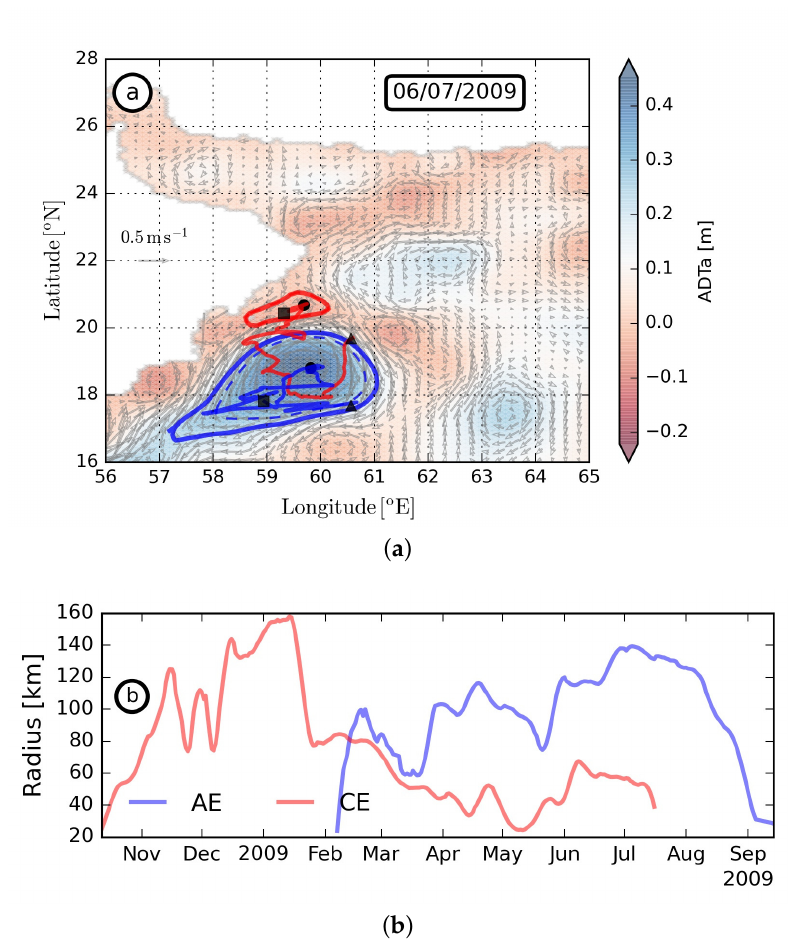
Figure A3. ( a ) Absolute Dynamic Topography anomaly for the 2009 year (snapshot); blue and red contours are for anticyclones and cyclones respectively, dashed contours are for eddy core, and solid contours for the last closed contour. The black dot represents the anticyclone and cyclone instantaneous center position. The solid red and blue trajectories are for cyclone and anticyclone, respectively during their lifetime. The black triangle and square represent the initial and final position of each eddy, respectively and ( b ) time series of the cyclone and anticyclone radii for year